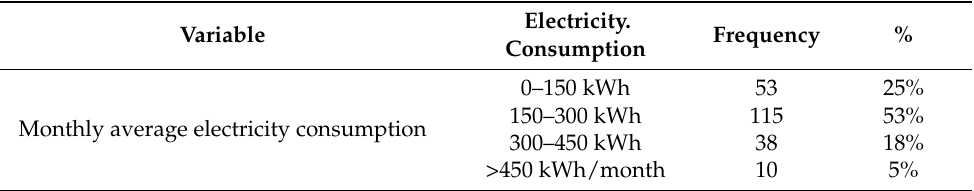
Table 2. Consumers’ electricity consumption profiles.